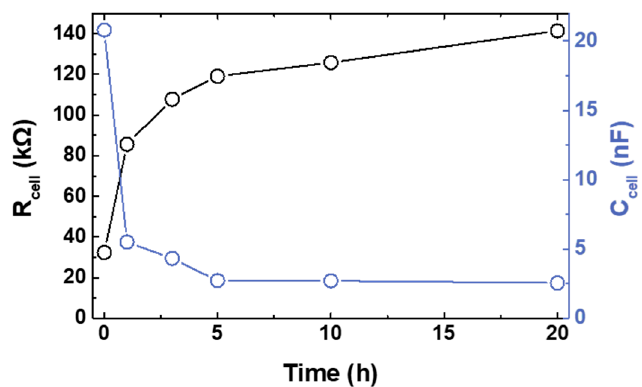
Figure 5. Measured resistance ( R cell ) and capacitance ( C cell ) of the ion-doped LC cell over time under an applied sinusoidal voltage wave (60 V, 100 Hz).